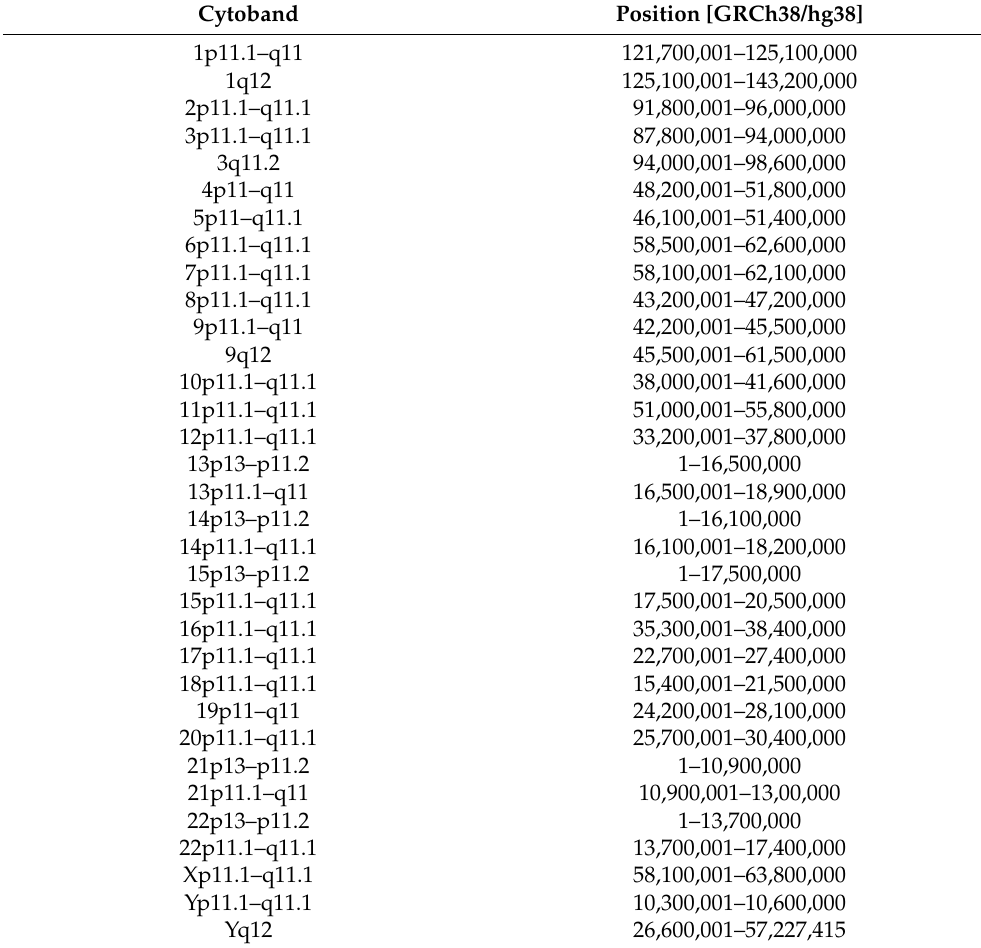
Table 2. Regions being affected by/involved in heterochromatic